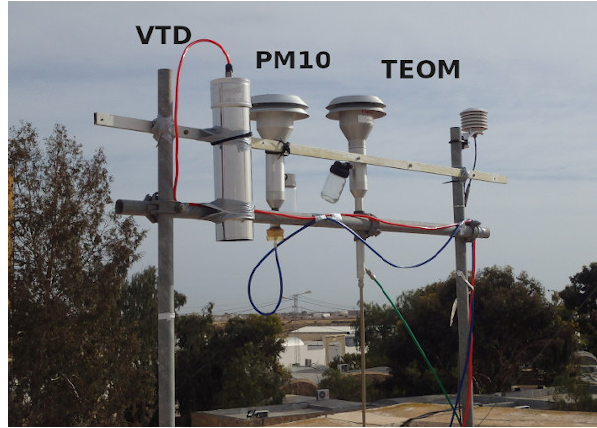
Figure 1. From left to right, the VTD system, the PM10 sampling head, and the TEOM. Both the TEOM and PM10 heads are from the same brand: Tecora™ PM10.